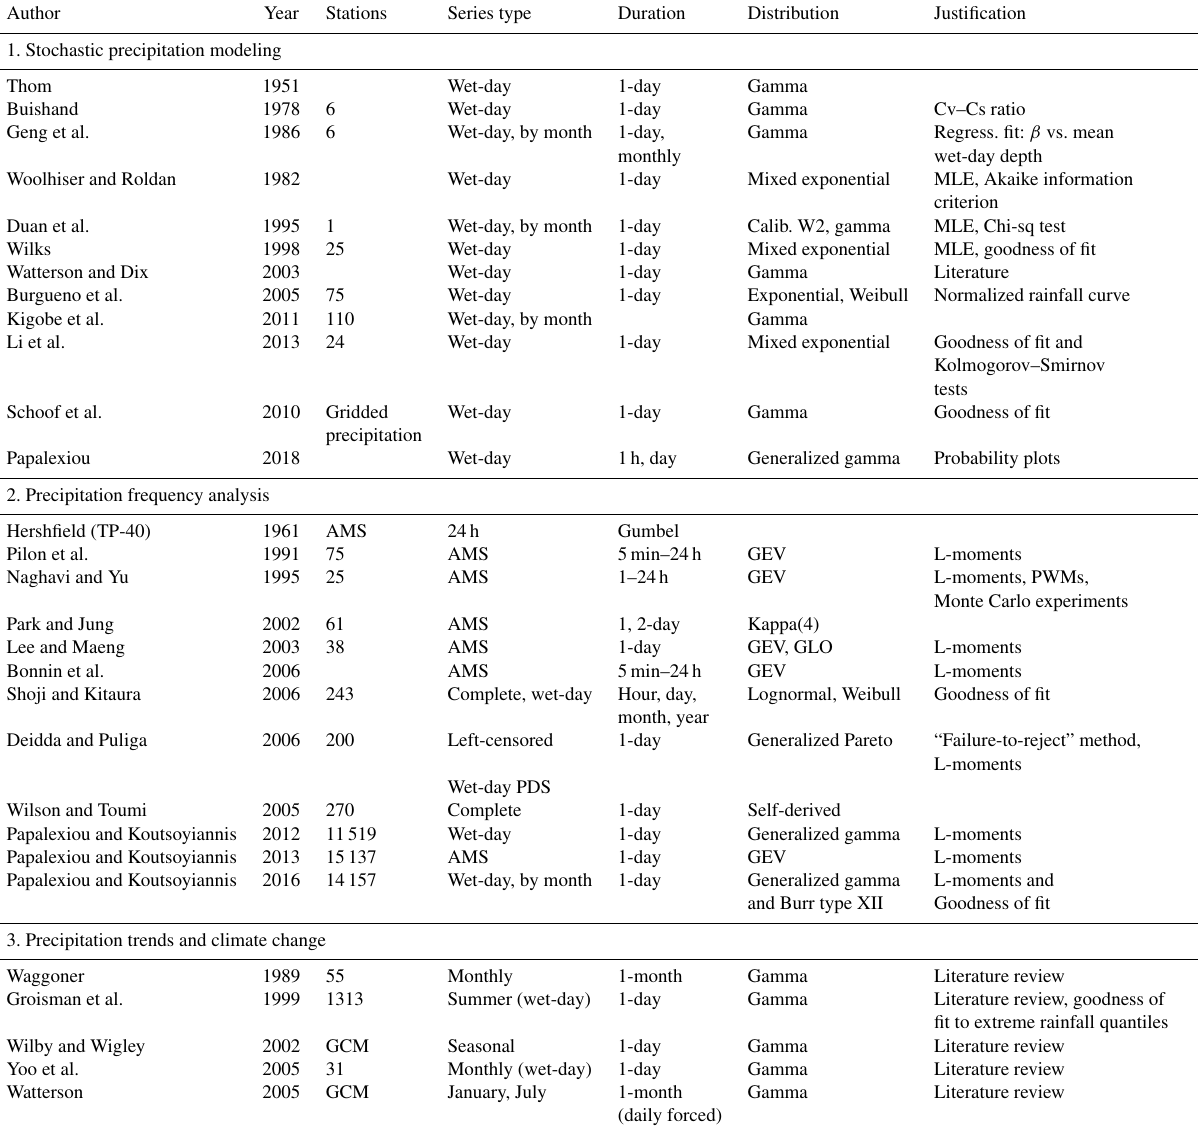
Table 1. Review of literature pertinent to daily precipitation probability distribution